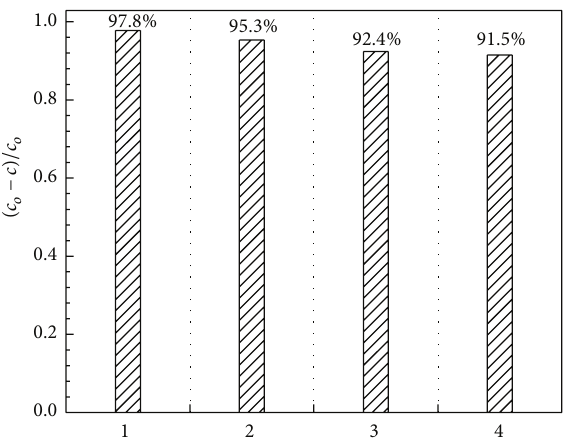
Figure 13: Removal efficiencies for 4 runs of 45 min.